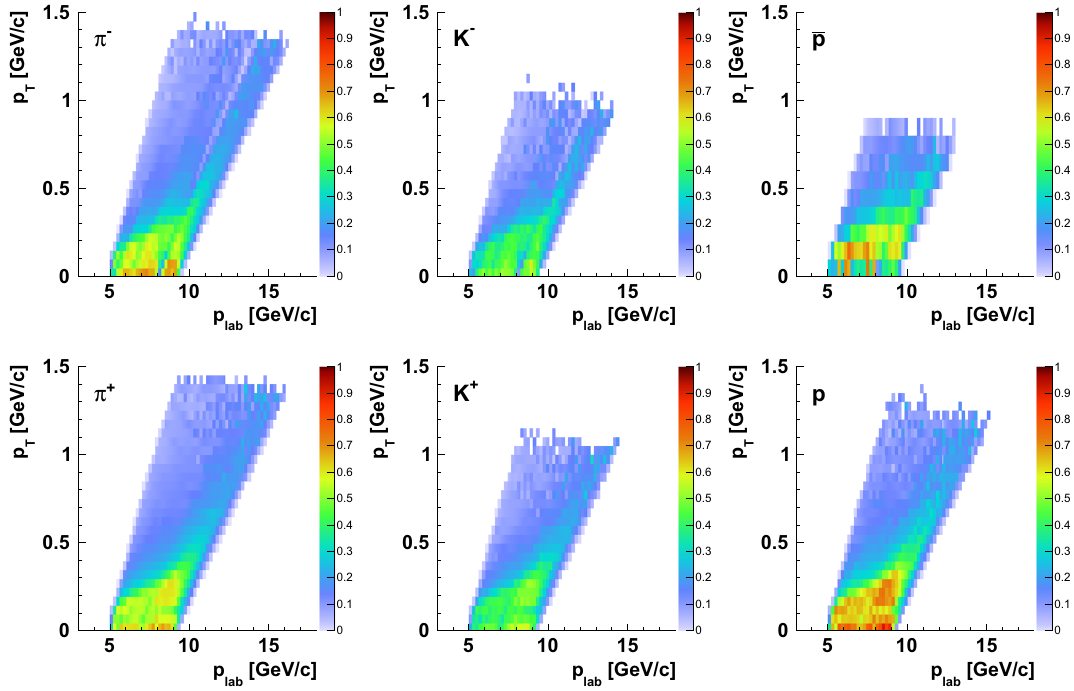
Fig. 15 Efficiencies C tof for the tof -d E / d x identification method for positively and negatively charged pions, kaons and protons for p + p i interactions at 158 GeV /